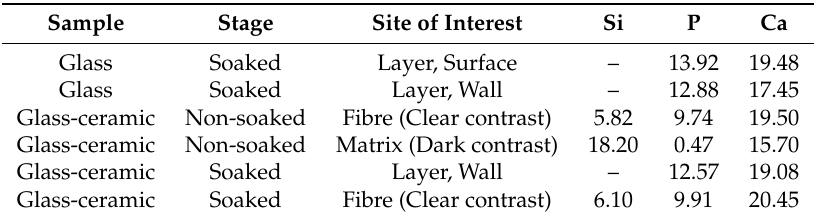
Table 3. EDX compositional analysis in at % of the microstructure found in the W-TCP machined glass and glass-ceramic samples.